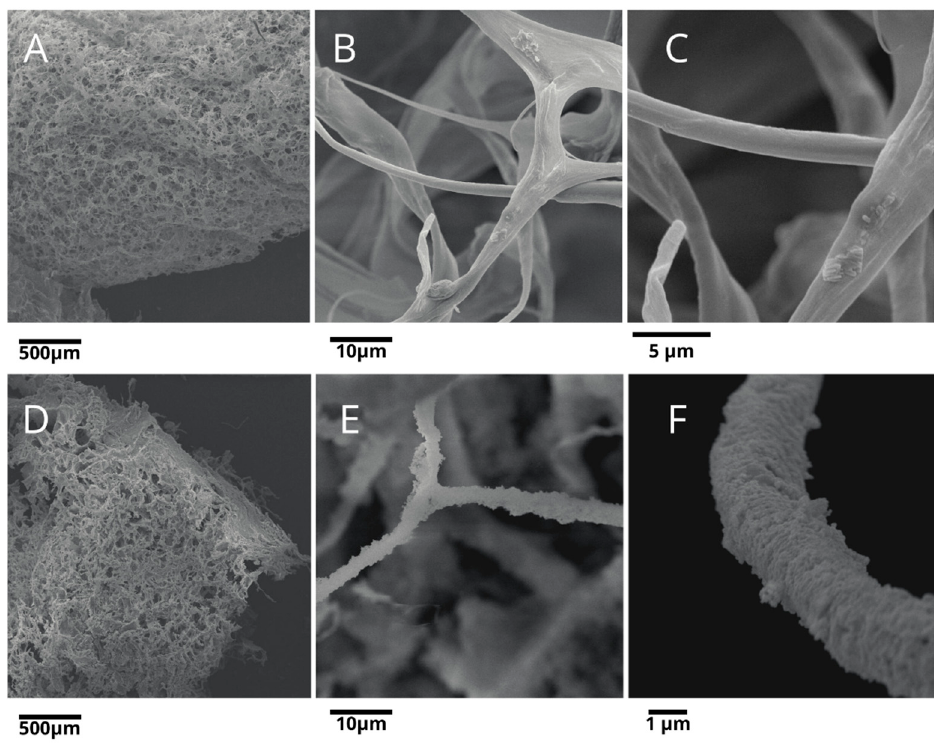
Figure 3. SEM images of the AmHA ( A – C ) and OmHA composites ( D – F